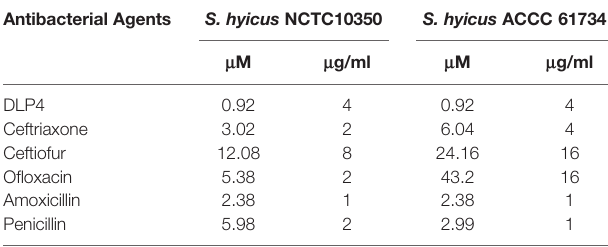
TABLE 1 | MIC assay of DLP4 and antibacterial agents against S. hyicus . Antibacterial